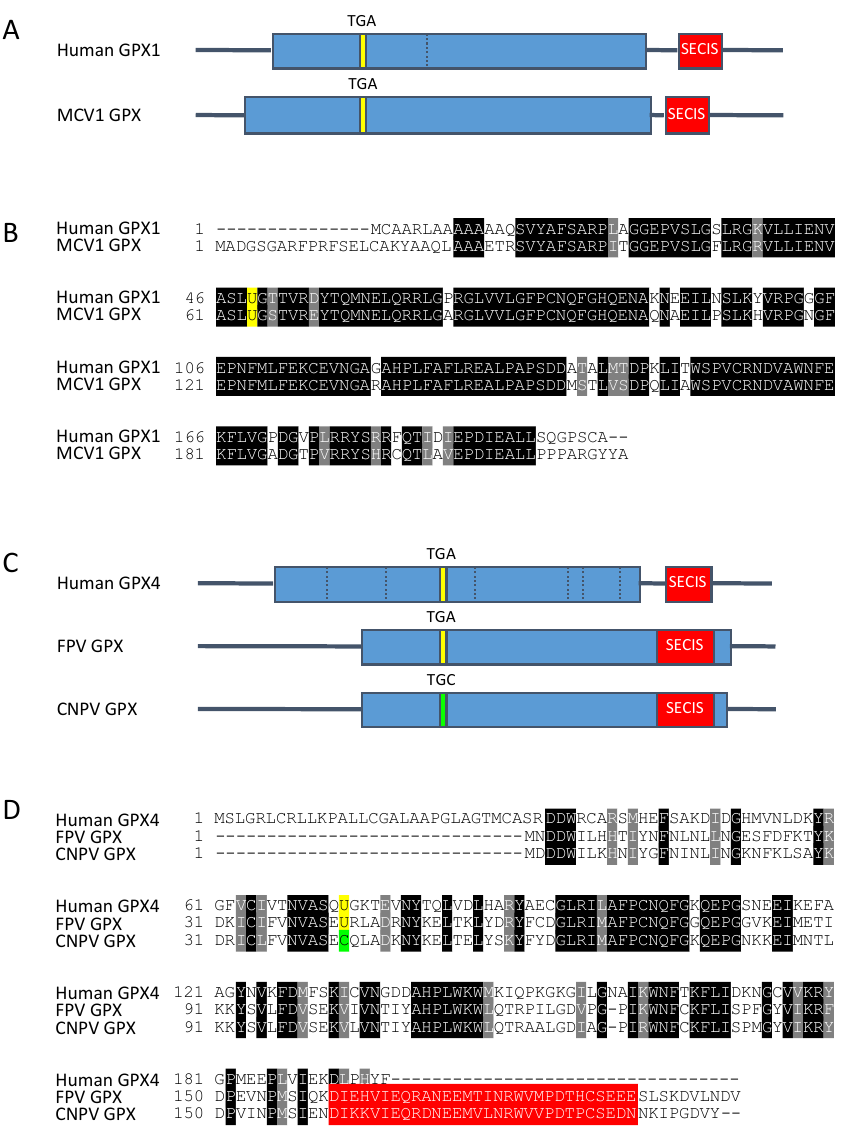
Figure 5. Gene structures and amino acid sequences of the selenoproteins present in the viral genomes of molluscum contagiosum virus subtype 1 (MCV1) ( A , B ) and of fowlpox virus (FPV) ( C , D ) in comparison with their respective human orthologs, GPX1 and GPX4 [175,176]. ( A ) Location of the typical features of a selenoprotein gene (coding sequence, TGA codon and SECIS element) in human GPX1 gene in comparison with those of MCV1 GPX gene. For clarity reasons, the introns of human gene have been removed, but the position of splice sites is indicated by a dashed bar. ( B ) Amino acid sequence alignment of human GPX1 (P07203) with MCV1 GPX (Q98234). Identical and similar amino acids in both sequences are highlighted in black and grey, respectively. The selenocysteine amino acid (U, in one-letter code) is highlighted in yellow. ( C ) Comparison of the location of selenoprotein gene features in human GPX4 gene with those of FPV GPX and Canarypox virus (CPV) GPX genes. The replacement of the TGA (selenocysteine) codon by a TGC (Cysteine) one in CPV GPX gene is indicated in green. ( D ) Amino acid sequence alignment of human GPX4 (P36969) with FPV GPX (Q70H87) and CPV GPX (Q6VZR0). In-frame SECIS elements in the C-terminal region of FPV GPX are highlighted in